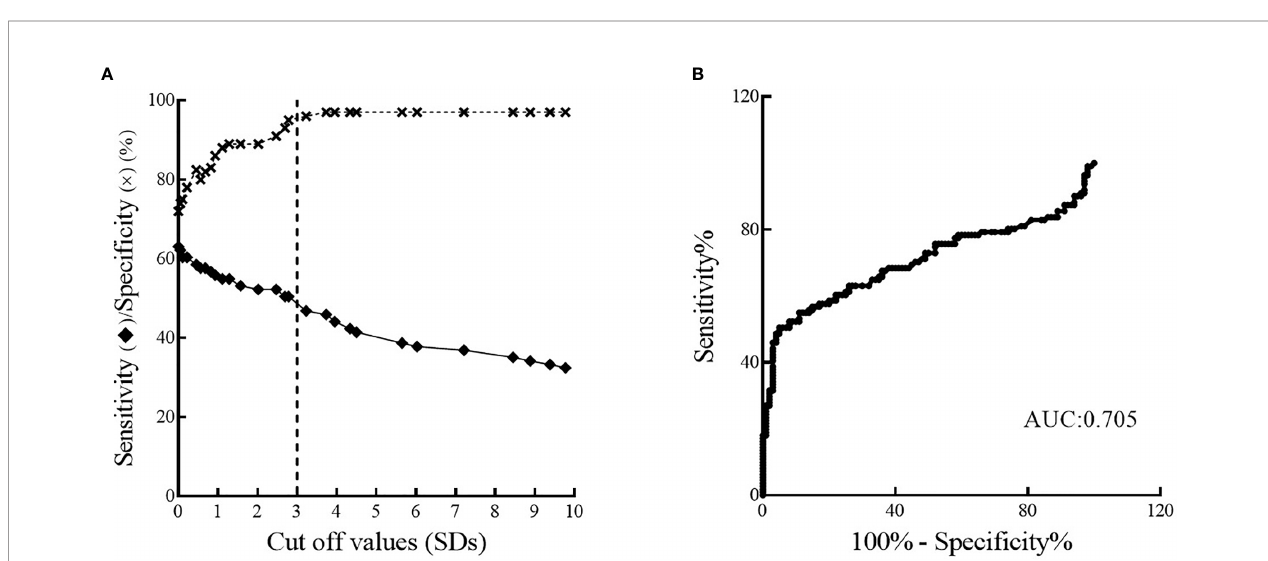
FIGURE 3 | Analysis of the performance of FloCMIA resulting from the study of 100 sera from normal control individuals and 111 sera from infant-juvenile patients with type 1 Diabetes. (A) Sensitivity curve (solid line) and speci fi city (broken line) as function of the possible cut-off values. The vertical dashed line indicates the cut- off value with the optimized sensitivity and speci fi city parameters (cut-off = 3.0). (B) ROC curve analysis of FloCMIA, AUC is